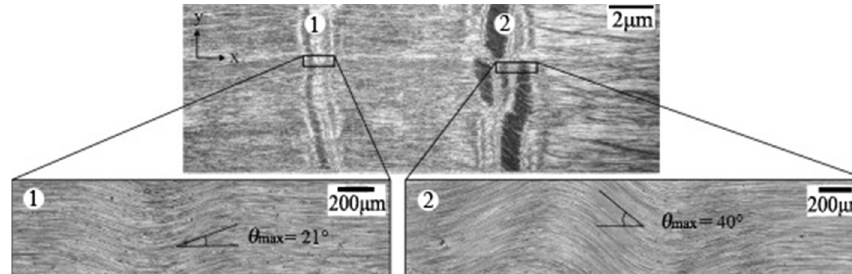
Figure 1. The out-of-plane wrinkle defects [15].